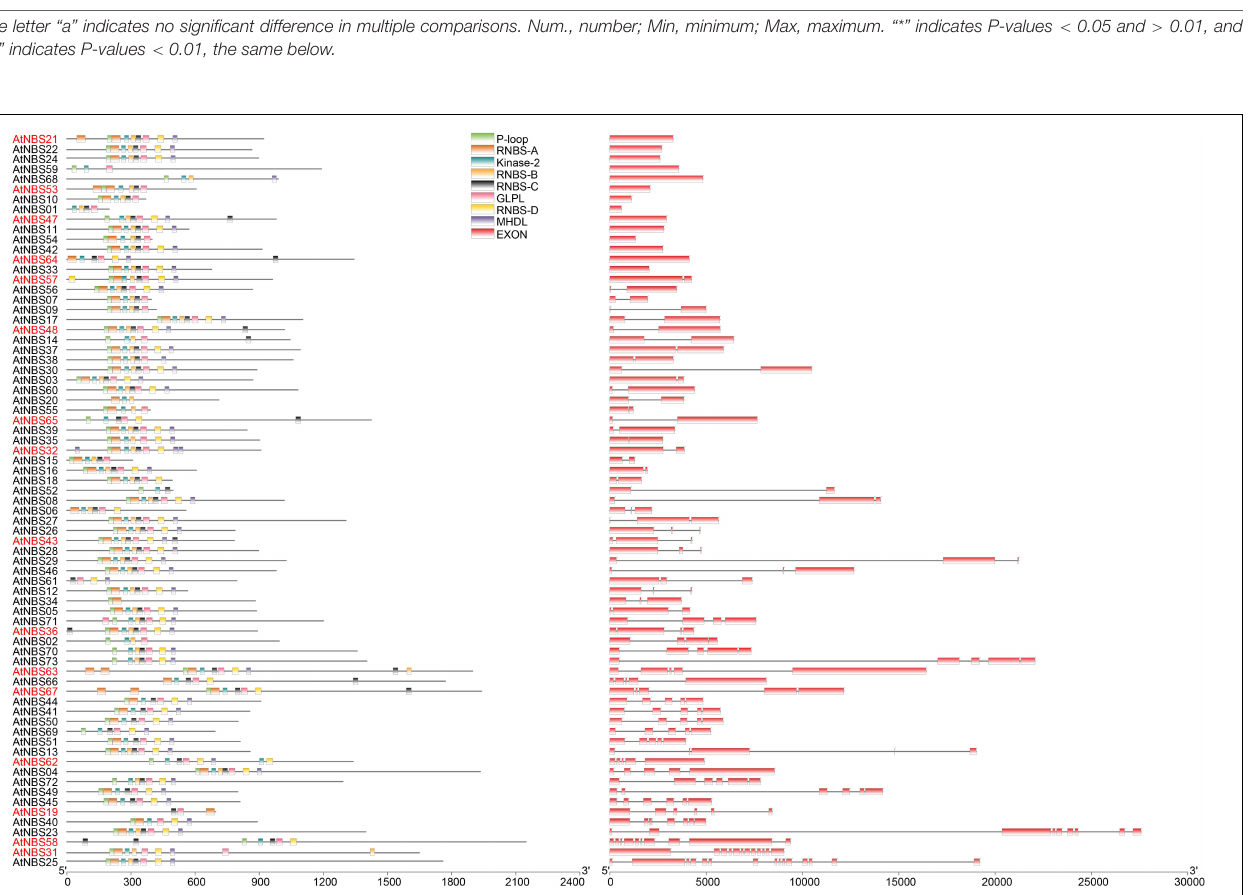
Frontiers in Plant Science |